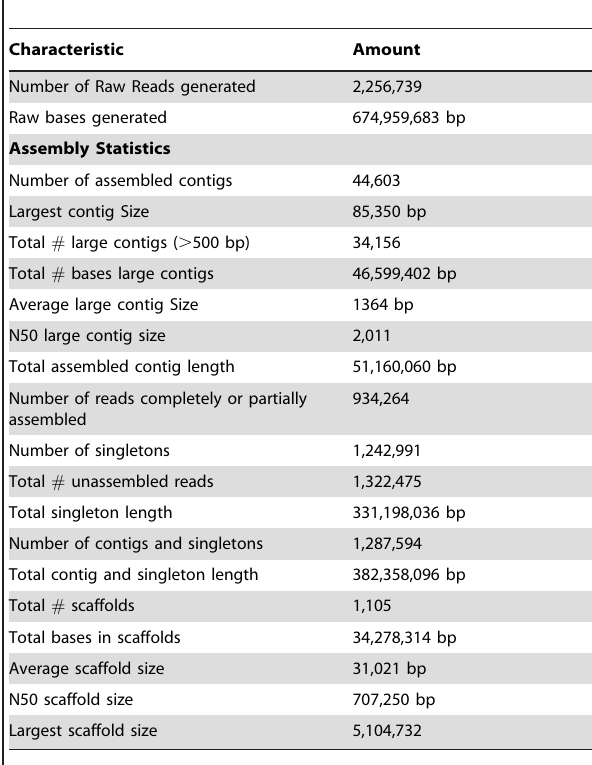
Table 1. Summary of the metagenome sequencing